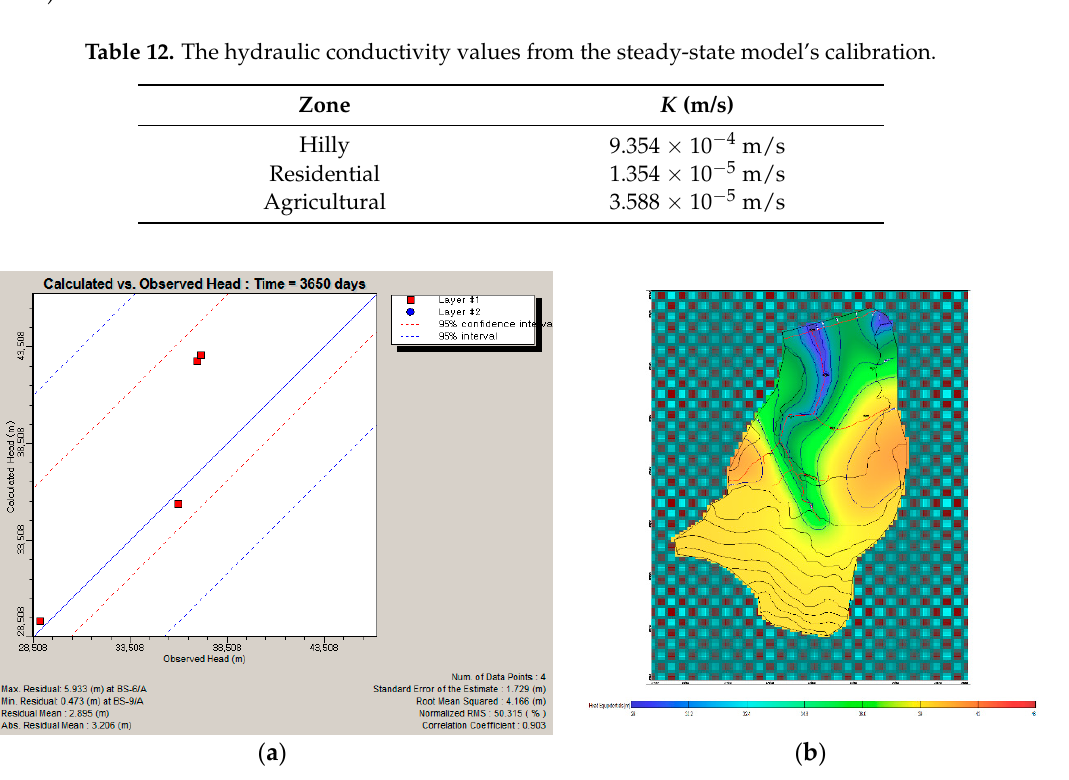
Figure 5. The ( a ) calculated versus observed levels and ( b ) groundwater level contours in the steady-state.